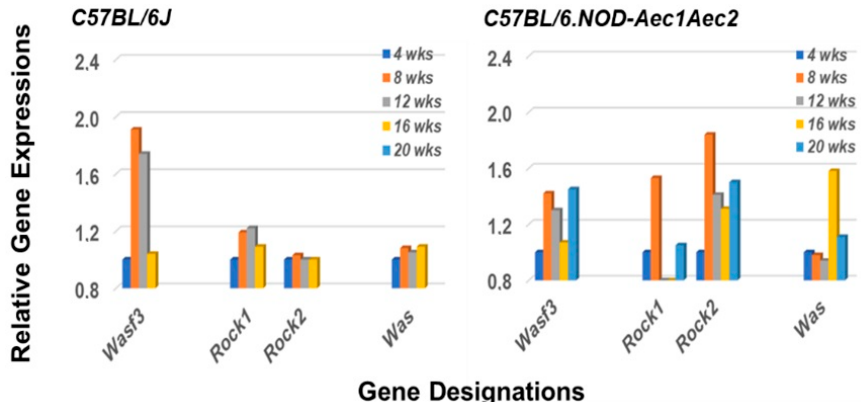
Figure 6. Rho-Arhgef pathway activations. Rho-Arhgef molecules are associated with several signal transduction pathways including Rac-GTP, Rho-GTP and CDC42-GP, each leading to downstream activation of a biological process important for cellular migrations. These three pathways inter- act, respectively, with Wasf, Rock, and Was protein family members. In the salivary glands of C57BL/6.NOD- Aec1Aec2 mouse these appear to be Wasf3, Rock1, Rock2 and Was (right panel). The genes encoding Wasf3 , Rock1 and Rock2 show an activation starting at 4 weeks of age, while the gene encoding Was is upregulated uniquely at 16 weeks of age. In the salivary glands of C57BL/6J mice, a strong activation is observed with Wasf3 , and possibly a weak response by Rock1 .